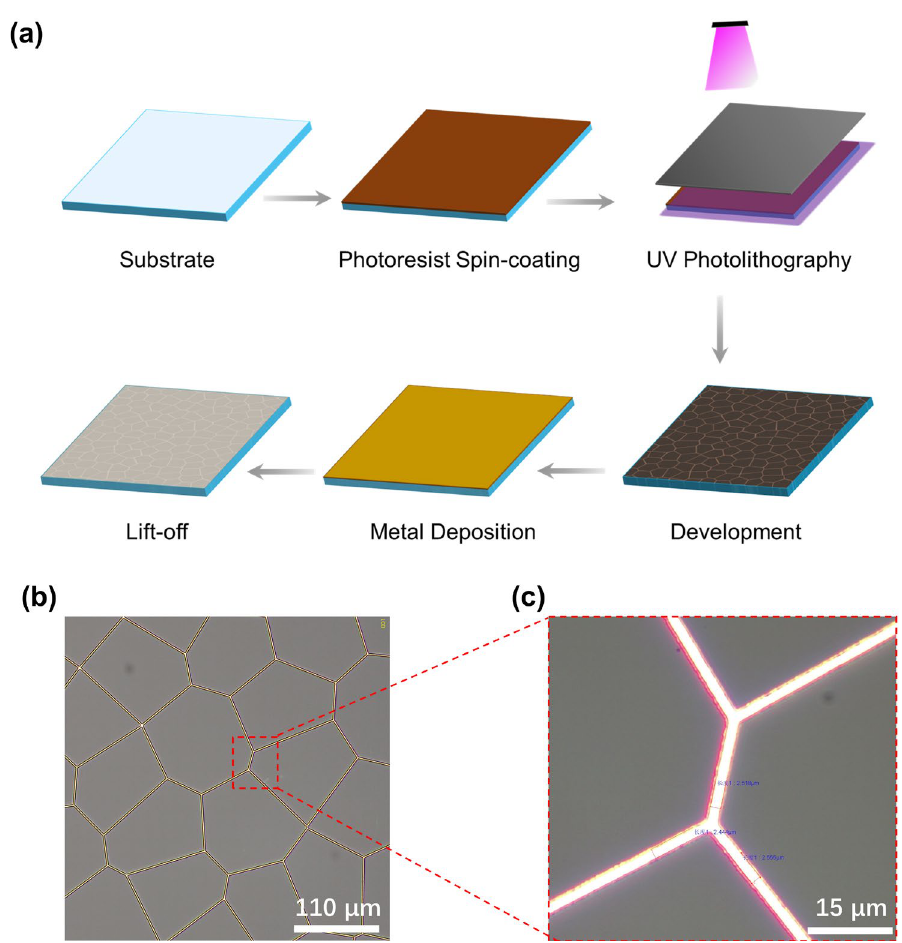
Figure 2. ( a ) Fabricating process of the IR transparent EMI shielding window. ( b ) Micrograph of metallic meshes under magnification of 50 × . ( c ) Measurement of linewidth under magnification of 400 ×